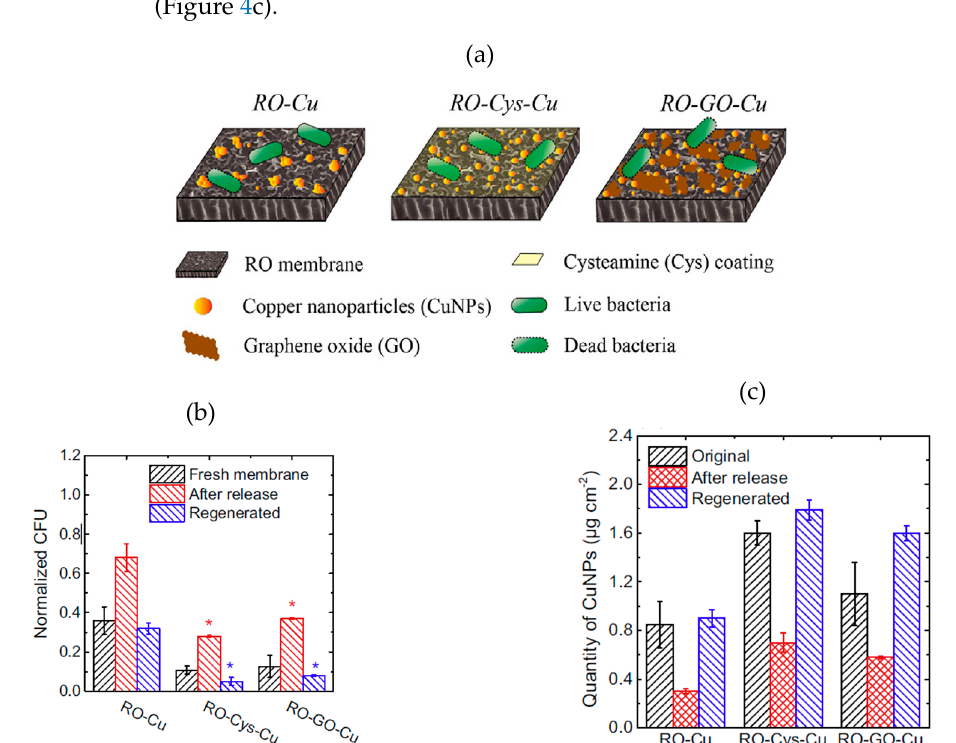
Figure 4. ( a ) Schematic of copper-modified RO membranes implemented by Ma et al. [79]. From left to right: Coating of membrane surface by in situ Cu-NPs reduction (RO-Cu), grafting of RO membrane with cysteamine linker and Cu-NPs (RO-Cys-Cu) and with graphene oxide linker and Cu-NPs (RO-GO-Cu); ( b ) Number of viable cells attached (CFU) in modified membranes compared to pristine membrane; ( c ) Quantity of NPs in each membrane after the release for a period of 7 days and after regeneration with Cu-NPs (note that the amount of NPs after regeneration is higher than the original amount of copper). Asterisks (*) indicate a statistically significant difference between the pristine and modified mem-branes ( p < 0.05). All images and graphs are extracted from